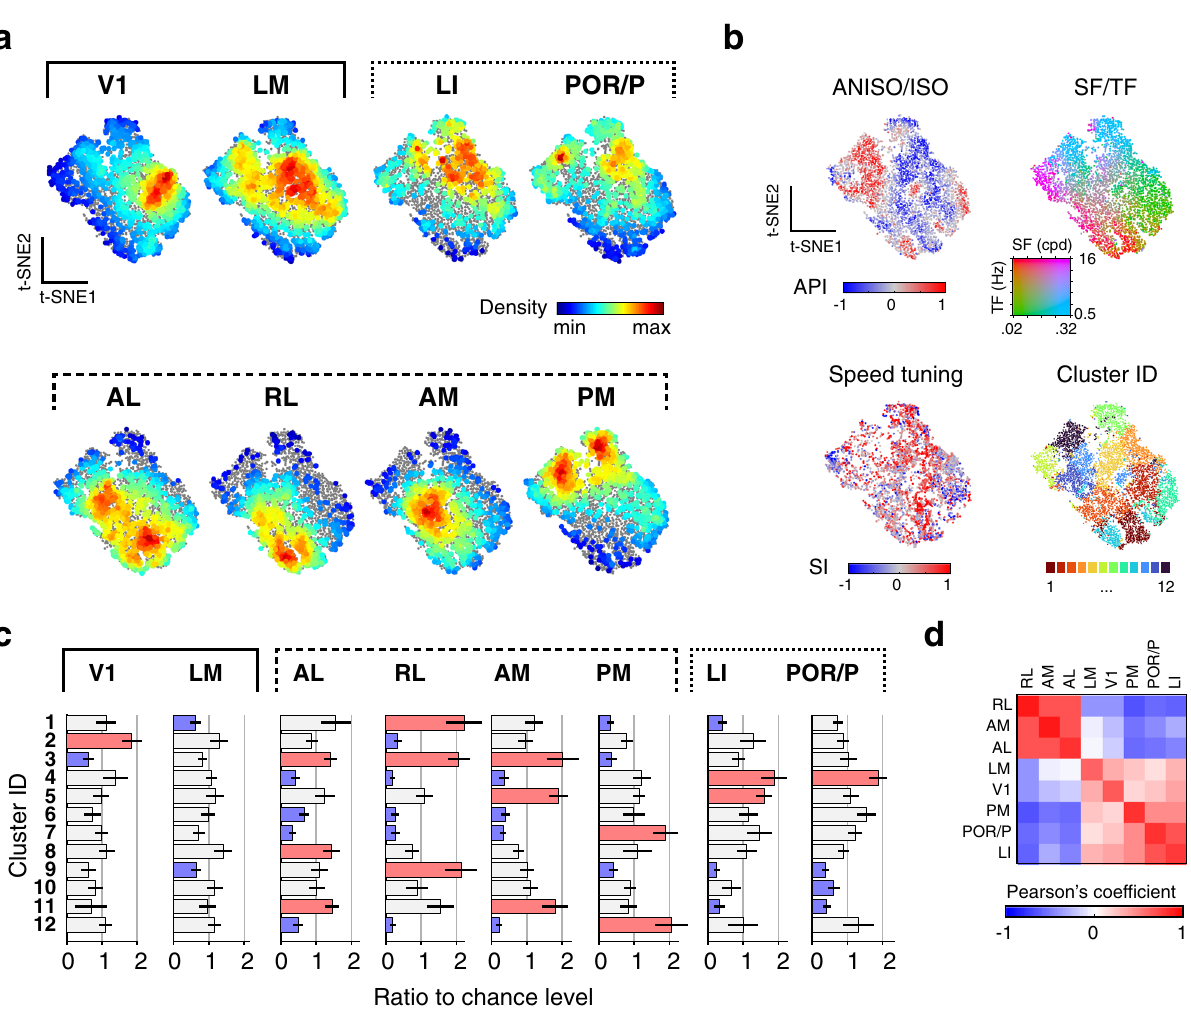
Fig. 8 Diversity of tuning underlying parallel processing streams. a t-SNE representations of the diversity of joint spatial and spatiotemporal tuning in response to isotropic and anisotropic stimuli within and across visual cortical areas (dataset in Fig. 7). Colored dots show the density of cells of particular tuning for each visual area (2000 randomly sampled neurons per area). Full dataset shown as gray dots in the background for reference. b Functional properties of neurons in the t-SNE representation, showing each cell ’ s ANISO/ISO preferences index (API, top left), peak spatial and temporal frequencies (top right), speed tuning indices of neurons (SI, bottom left), and cluster af fi liation (bottom right). c Bar plots show the representations of the clusters within each area, quanti fi ed as the ratio of clusters relative to chance level (1/12). Over- and underrepresented clusters are shown in red and blue, respectively; otherwise, gray. Mean ± s.e.m. (hierarchical bootstrapping, n = 1000 random repetitions). d Pearson ’ s correlation coef fi cient of cluster representations between visual areas. Note the anticorrelated representations of tuning in anterior dorsal and ventral areas (AL, AM, RL vs. LI and POR/P). Note also how the tuning representation in area PM differs from that of other dorsal